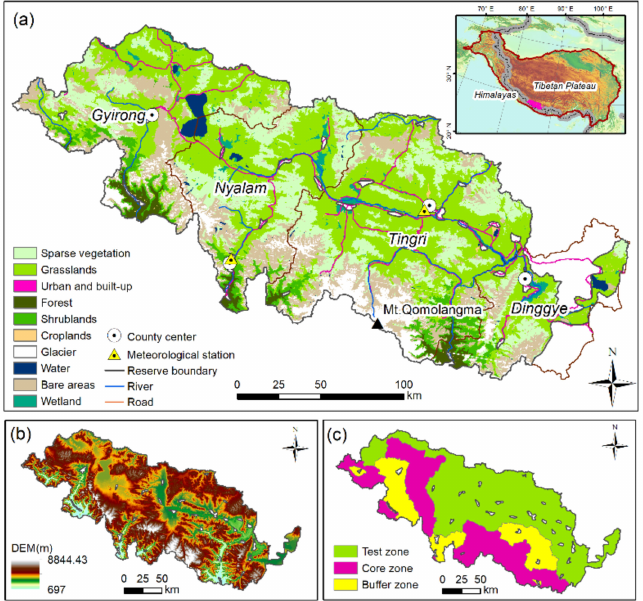
Figure 1. Study area: ( a ) Land cover types. ( b ) Topographic and altitudinal details. ( c ) Distributions of different protected zones. The boundary of the TP obtained from the study by Zhang et al. [46]. Land cover data obtained from the study by Nie [47]. Core zones (red color in ( c )) are well-preserved natural ecosystems with concentrated distributions of rare and endangered animals and